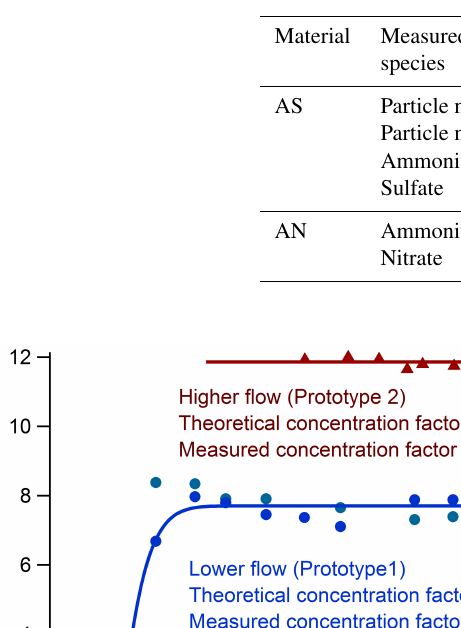
Table 2. Measured and theoretical concentration factors (CFs) for ammonium nitrate (AN) and ammonium sulfate (AS) obtained in the laboratory tests.